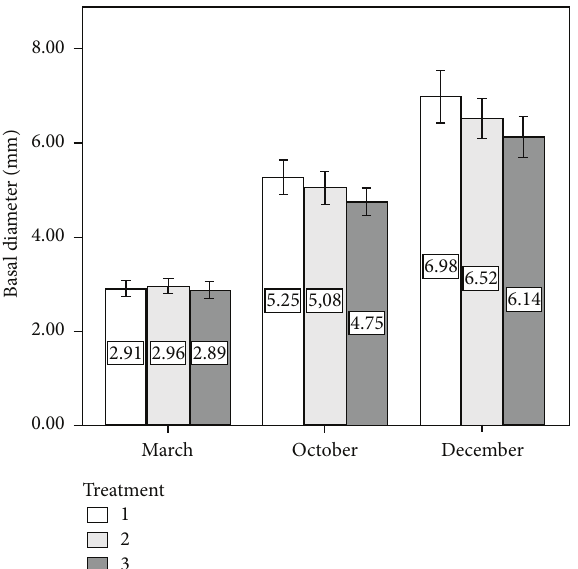
Figure 2: Growth height according to tree shelter factor. Treatment 1: control. Treatment 2: seedlings with 120cm shelters. Treatment 3: seedlings with 150cm shelters. Values sharing the same letter within same date are not significantly different at 5% by the Scheff´e test.